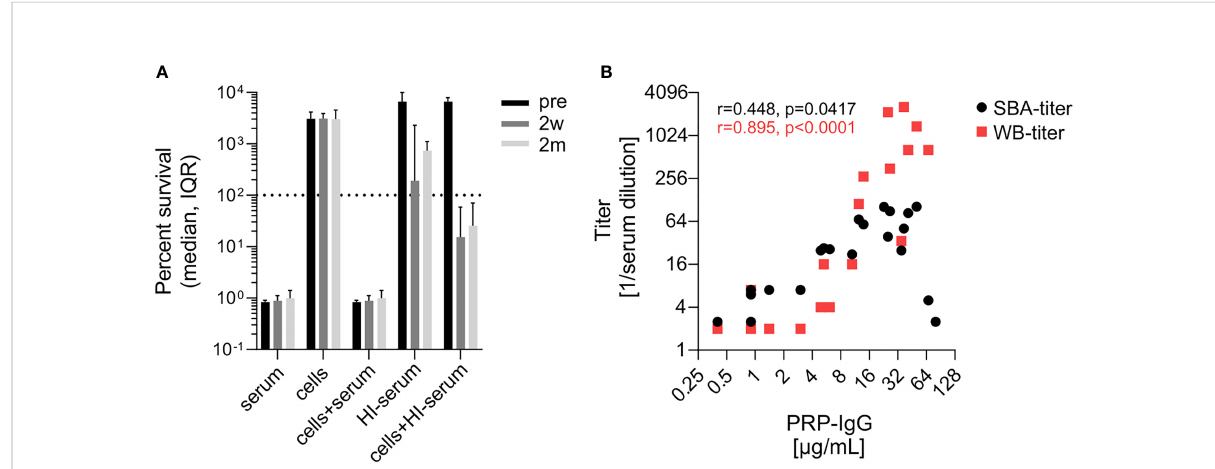
FIGURE 5 Evidence for complement-independent antibody-mediated opsonophagocytic killing of Hib isolate 23393. (A) Killing of Hib isolate 23393 incubated with serum, PBS-washed blood cells, blood cells supplemented with complement-preserved serum, heat-inactivated (HI) serum or blood cells supplemented with HI serum. Cumulated data for all subjects are shown. (B) Correlation of bactericidal titers in the SBA and in the reconstituted whole blood assays with the serum anti-PRR IgG concentrations. The Pearson ’ s correlation analyses include titers assessed pre- vaccination (Pre), 2 weeks (2w) and 2 months (2m) post vaccination. Whole blood killing titers were determined using blood cells reconstituted with serial dilutions of HI human serum and 20% active baby rabbit serum. Titers represent the reciprocal of the serum dilution which yielded >50% killing after 3 hours of incubation. A value of 2 was given to sera with titers below the threshold of 4. WB, reconstituted whole blood assay. Two outlier data points in (B) with high anti-PRP IgG titer and low SBA titer correspond to the results obtained with strain 23393 and the two post-vaccination sera (2w and 2m) of subject 2 (see Figure